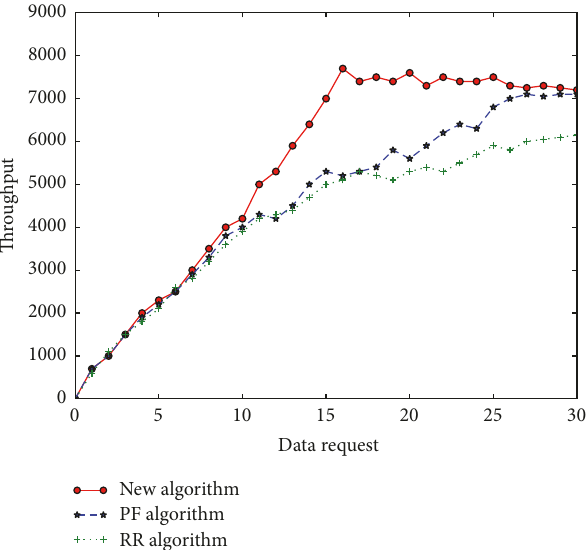
Figure 4: System throughput under different